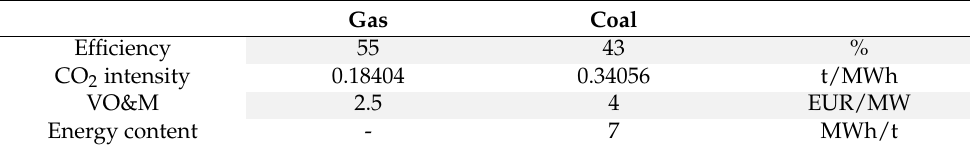
Figure 2. Daily short-run marginal costs (SRMC) of gas and coal and German day-ahead electricity price. Table 1. Parameters used for calculating the short-run marginal costs of coal and gas. Gas Coal Efficiency